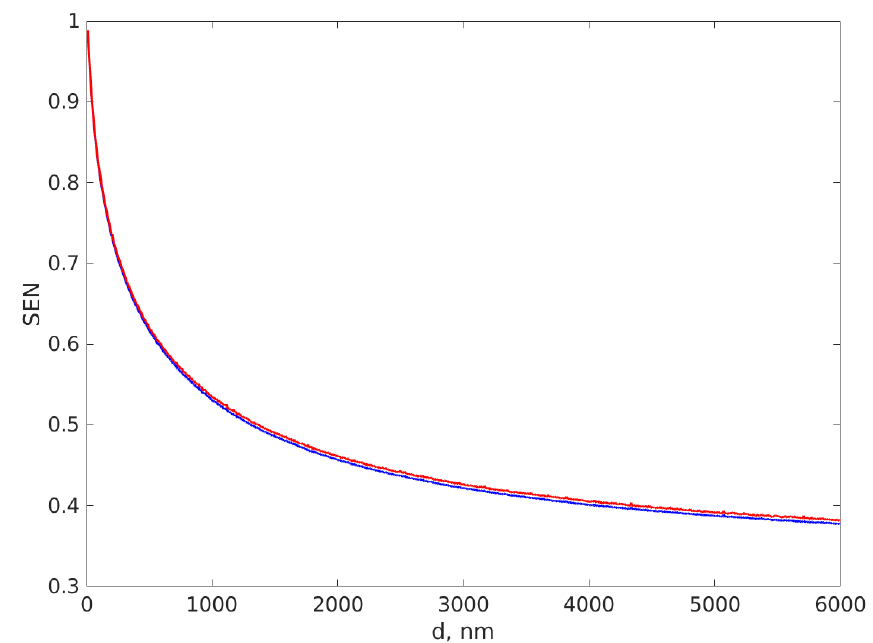
Figure 3. The SEN vs. the diameter used for TS generation. The blue dots stand for the clean TS SEN and the red dots for the noisy TS SEN.